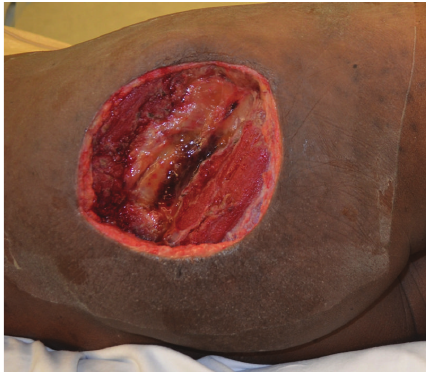
Figure 1: A 15 × 15cm right gluteal defect following resection of a high-grade pleomorphic undifferentiated sarcoma following neoadjuvant radiation therapy.